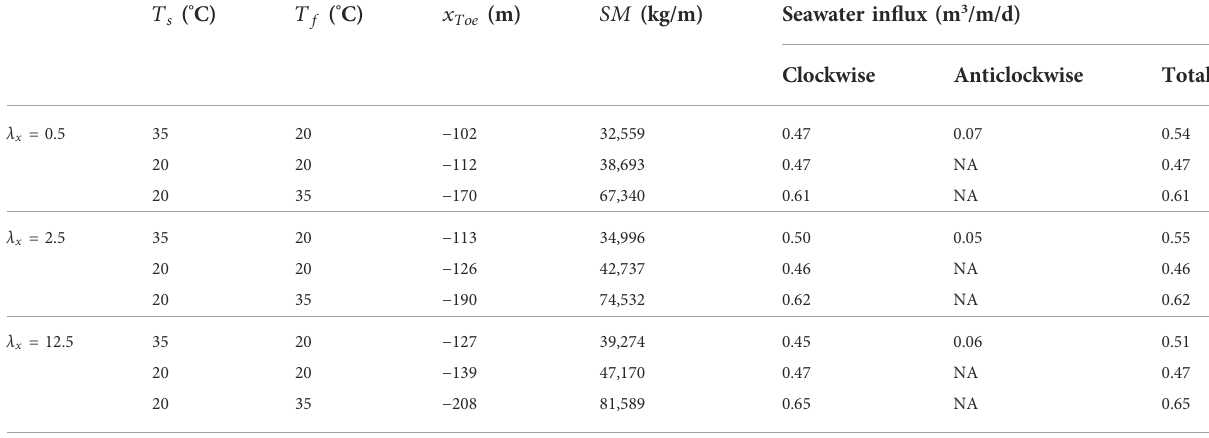
TABLE 3 Key results for heterogeneous cases with different correlation lengths and FW-SW temperature contrasts.